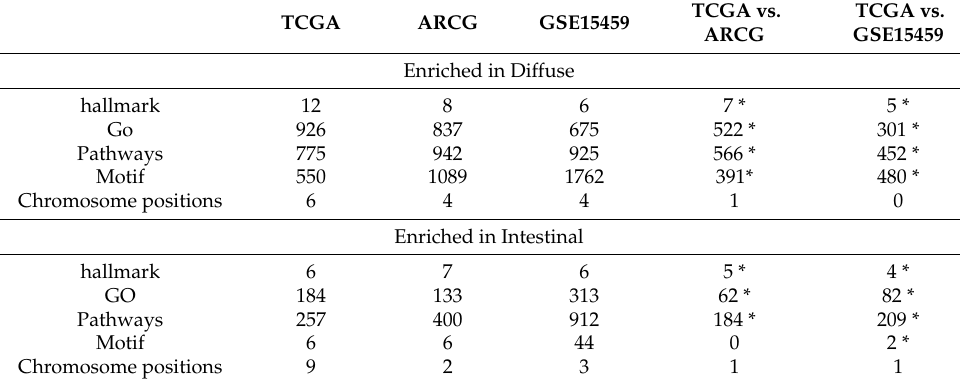
Table 3. Summary of the differentially enriched categories between Diffuse and Intestinal GC in TCGA, ARCG and GSE15459 dataset. Statistically significant ( p -value < 0.01) overlaps are in